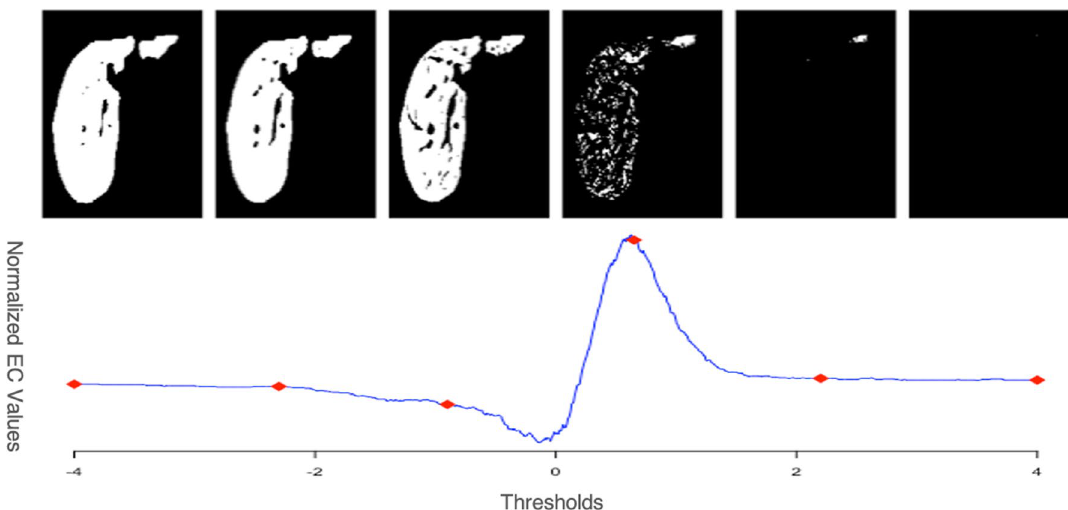
Figure 5. An example EC curve defined across varying thresholds and its corresponding image of excursion